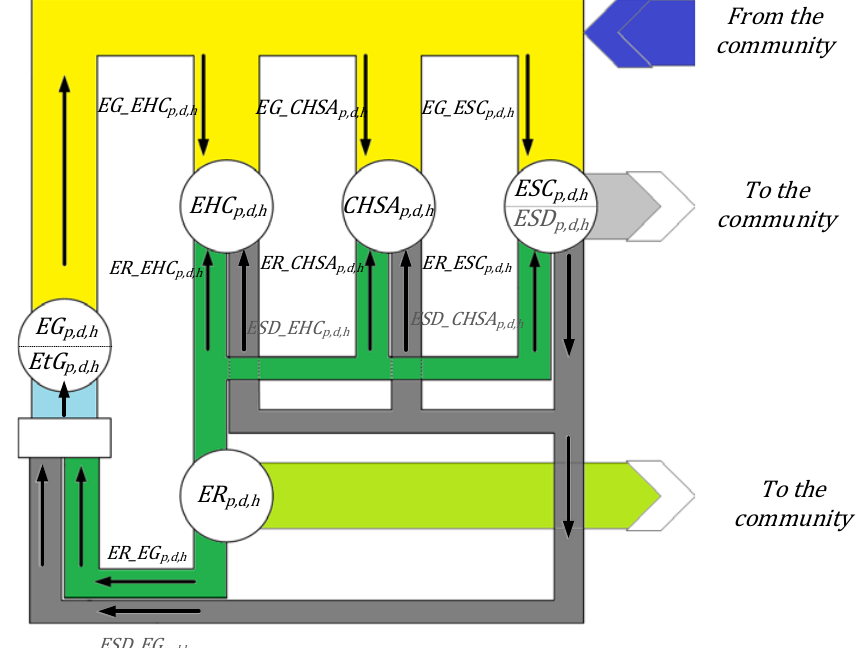
Figure 2. Representation of the physical model of one prosumer that belongs to the energy community. Source: self-elaboration.